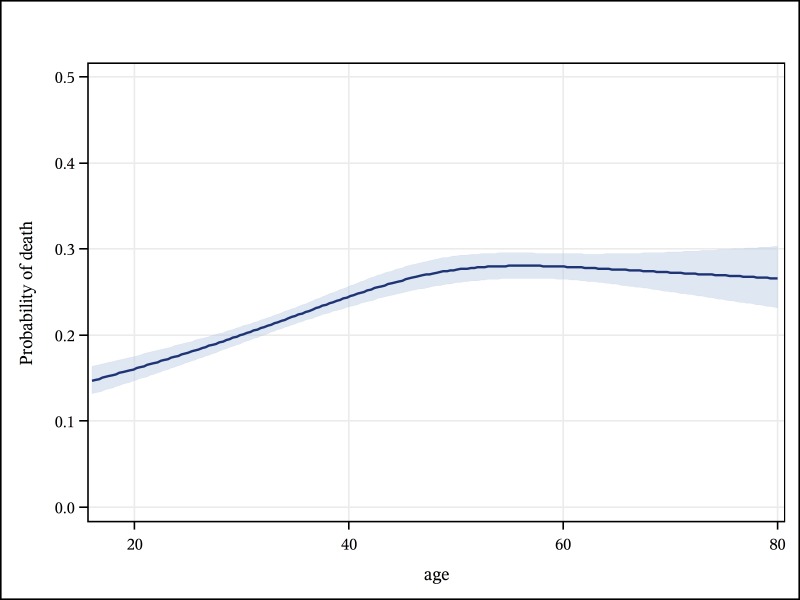
Predicted probablility (with 95% confidence limits) of a death, by age, in adult inpatients, Blantyre, Malawi- 2013 to 2014.